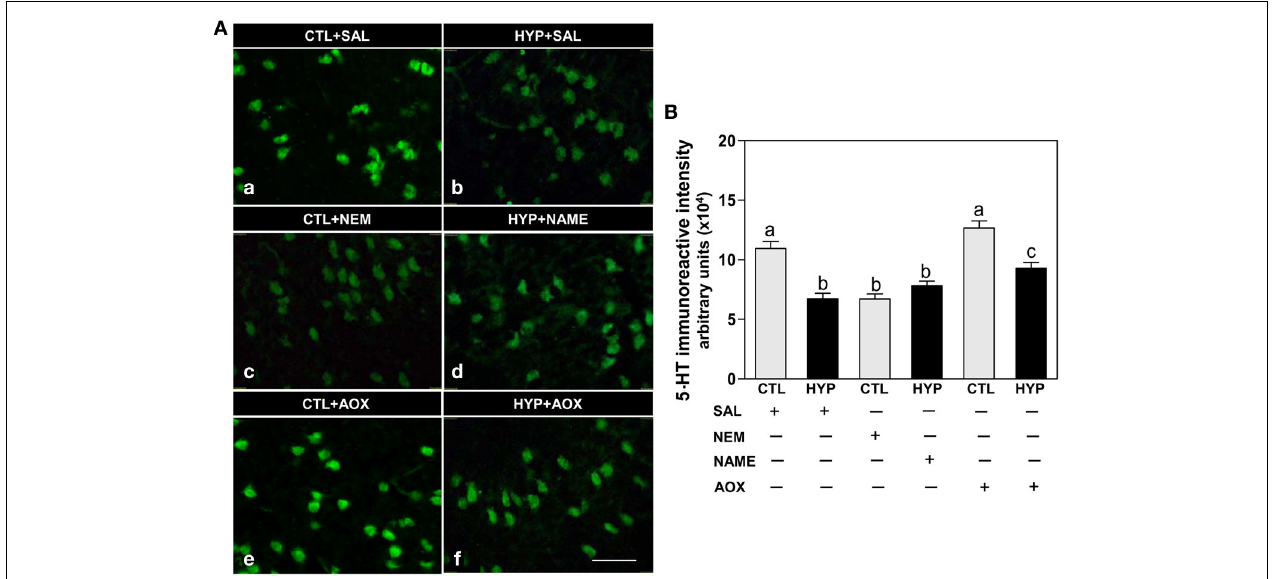
FIGURE 5 | Interactive effects of hypoxia and pharmacological agents that modulate generation of ROS and RNS on 5-HT content in neurons assessed by immunohistochemistry in croaker hypothalamus. Effects of hypoxia (DO: 1.7mg/L for 4 weeks) exposure and pharmacological treatments with NEM, NAME, and AOX on immunohistochemical (IHC) expression and immunoreactive (IR) intensity of 5-HT neurons in croaker hypothalamus. (A) Representative IHC micrographs of 5-HT neurons in hypothalamic